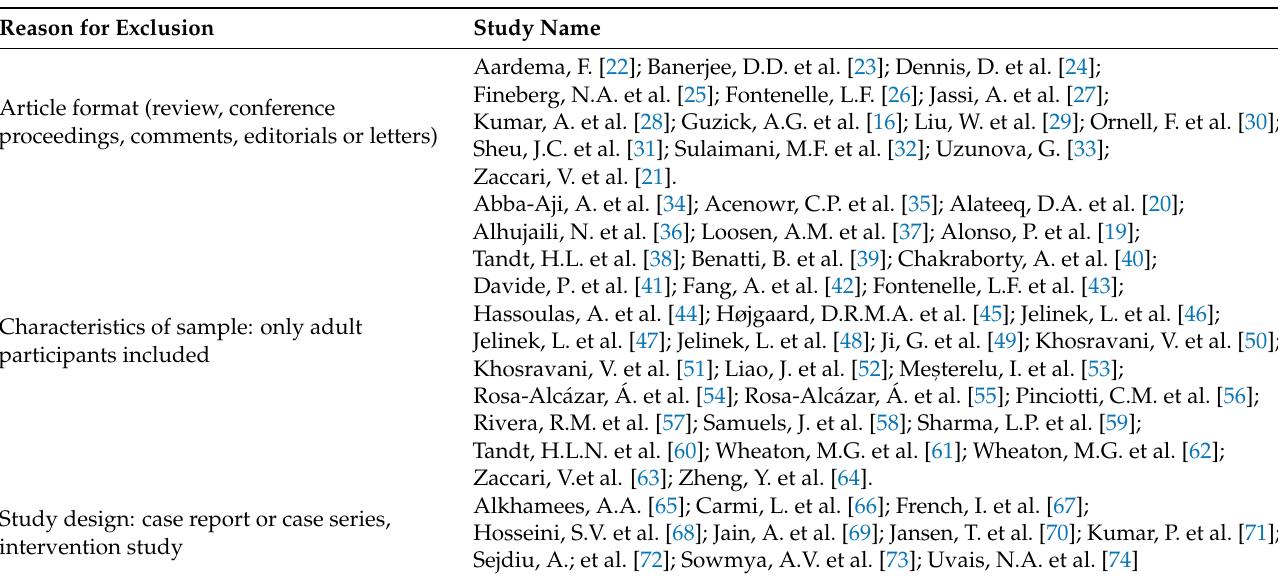
Table 1. List of excluded studies along with reasons for